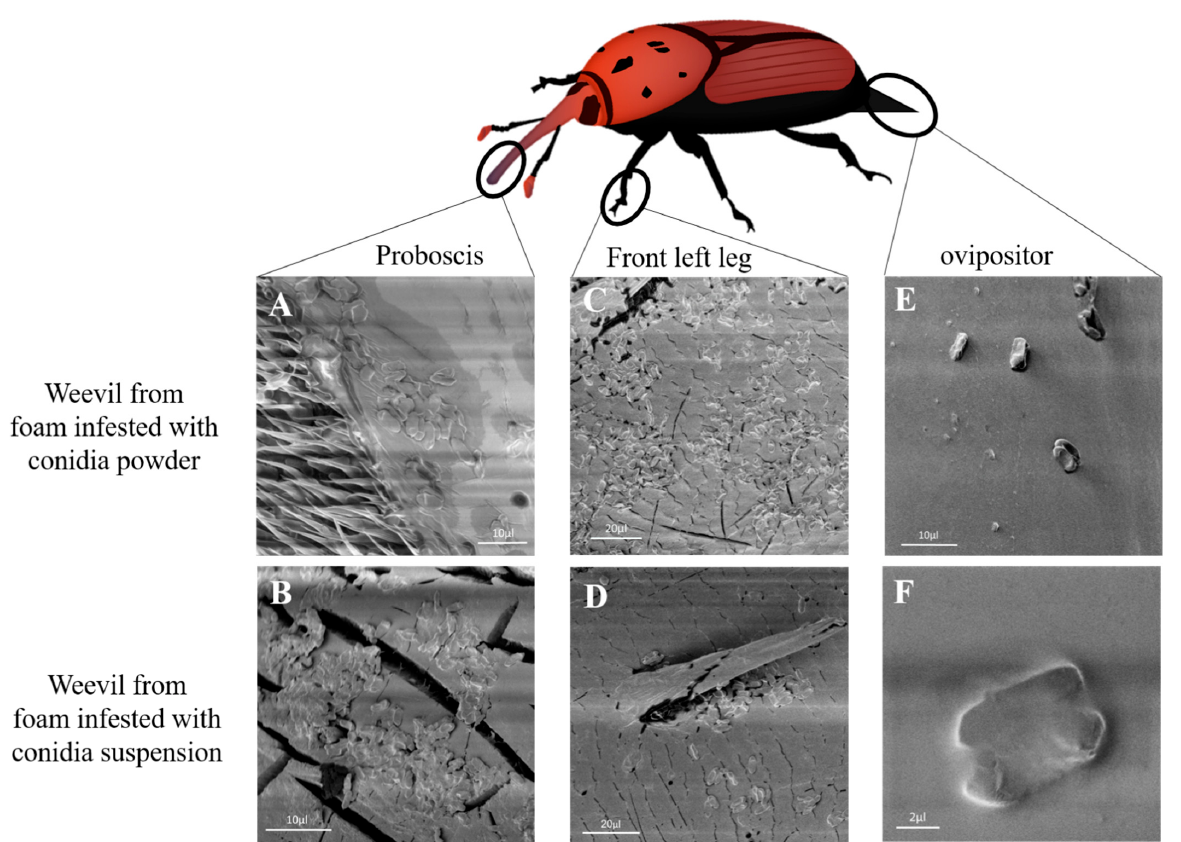
Figure 5. Scanning electron micrograph of female weevil proboscis ( A , B ), front leg ( C , D ) and ovipositor ( E , F ) after exposure to foam treated with Mb7-GFP conidia powder 5 × 10 8 conidia total ( A , C , E ) or foam treated with conidia suspension 10 8 conidia mL − 1 ( B , D , F ). Scale bar designated for each micrograph. J. Fungi 2023 , 9 , x FOR PEER REVIEW